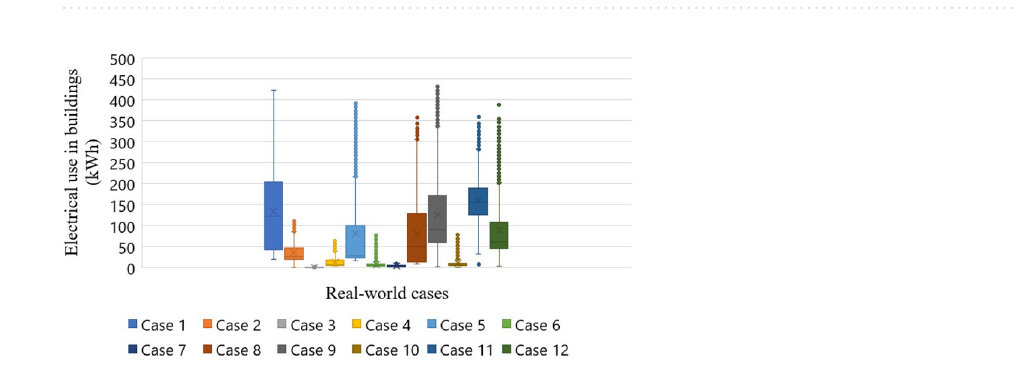
Figure 6. Electricity use profiles in 30-min resolution in 12 case studies.